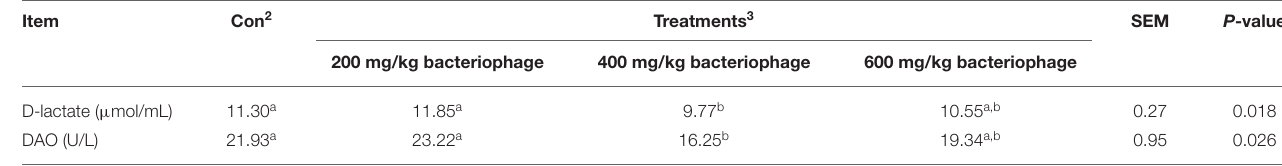
TABLE 6 | Effect of dietary bacteriophage supplementation on the D-lactate concentration and DAO activity of piglets fed antibiotic-free diet ( n = 5) 1 . Item Con 2 Treatments 3 SEM P -value 200 mg/kg bacteriophage 400 mg/kg bacteriophage 600 mg/kg bacteriophage D-lactate ( µ